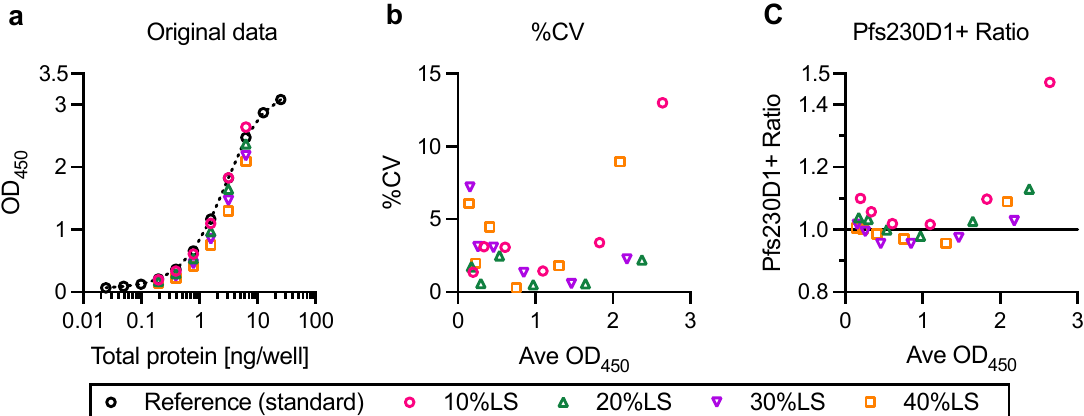
Figure 2. Representative AIA result from a single assay. ( a ) Serial dilutions of reference Pfs230D1+ (no BSA, standard), or 4 different mixtures of Pfs230D1+ and BSA were evaluated by AIA. The mass ratio between Pfs230D1+ and BSA in 10%LS, 20%LS, 30%LS and 40%LS mixtures were 9:1, 8:2, 7:3 and 6:4, respectively. ( b ) Using the standard curve, OD 450 value in each test well was converted to Pfs230D1+ concentration (Obs-conc). Percent coefficients of variance (%CV) of Obs-conc in triplicate wells for each test sample at each dilution are shown. The x -axis shows average OD 450 value in triplicate wells for the test condition. ( c ) The average Obs-conc in triplicate wells was compared with the corresponding theoretical Pfs230D1+ concentration (Theo-conc) to obtain Pfs230D1+ Ratio. CV values were lower than 5% between ~0.5 and ~2.0 OD 450 range (Figure 2b), and